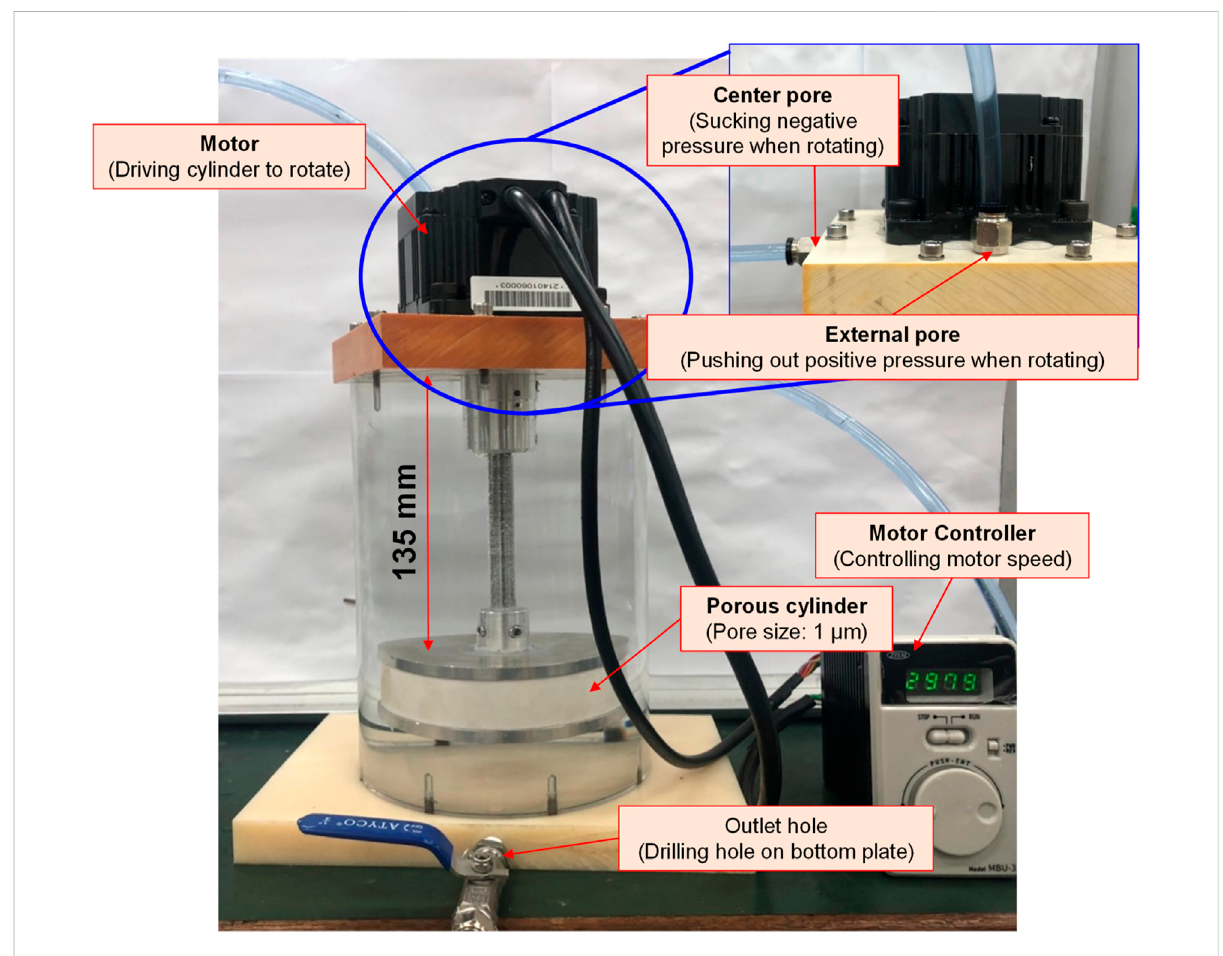
FIGURE 5 Physical layout of bubble re fi ning device for porous disc rotary cutting.